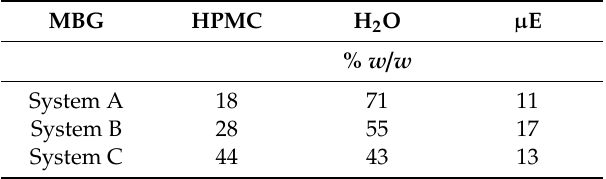
Figure 2. HPMC-based MBGs of different water content. System A: HPMC = 18% w / w , H 2 O = 71% w / w , µE = 11% w / w ; System B: HPMC = 28% w / w , H 2 O = 55% w / w , µE = 17% w / w ; System C: HPMC =